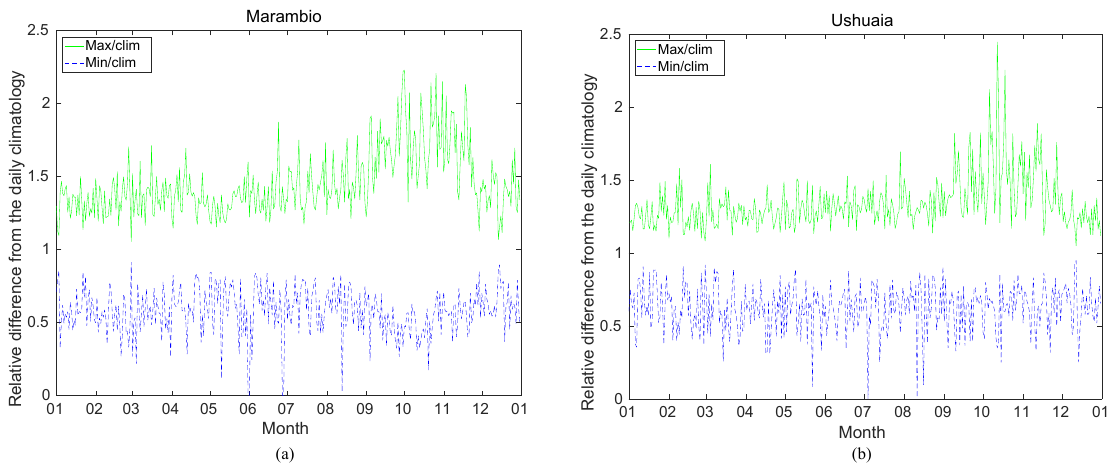
Figure 8. The maximum and minimum values of the daily maximum UV index divided by the daily climatology of the maximum UV index on that day in (a) Marambio and (b) Ushuaia during